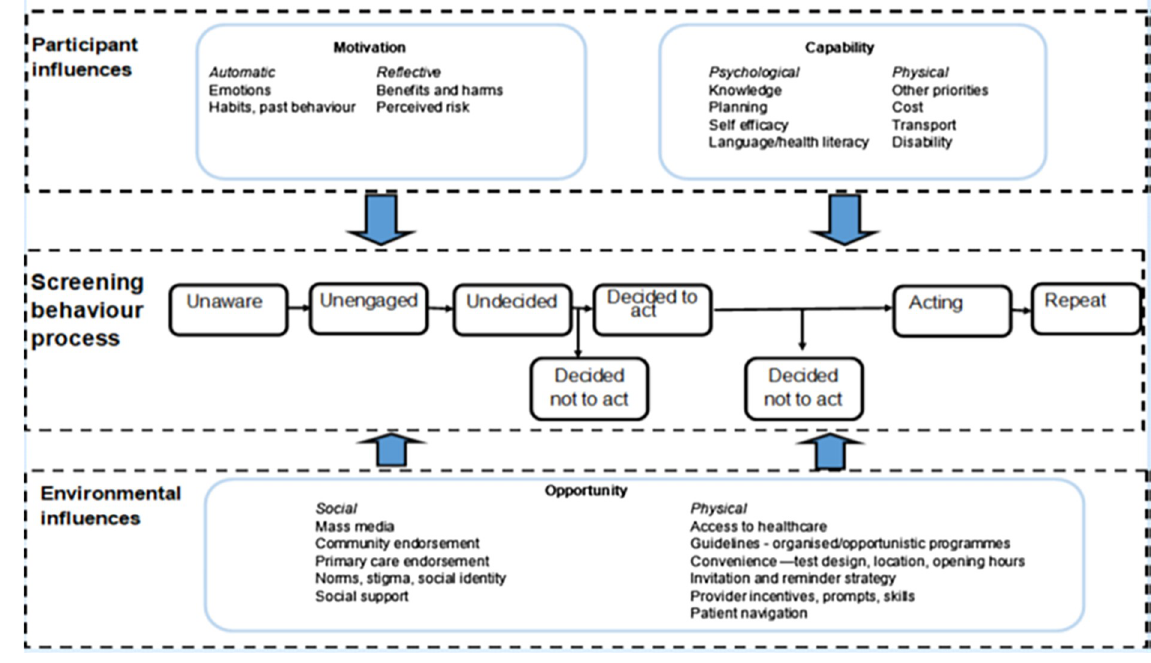
Fig 1. The integrated screening action